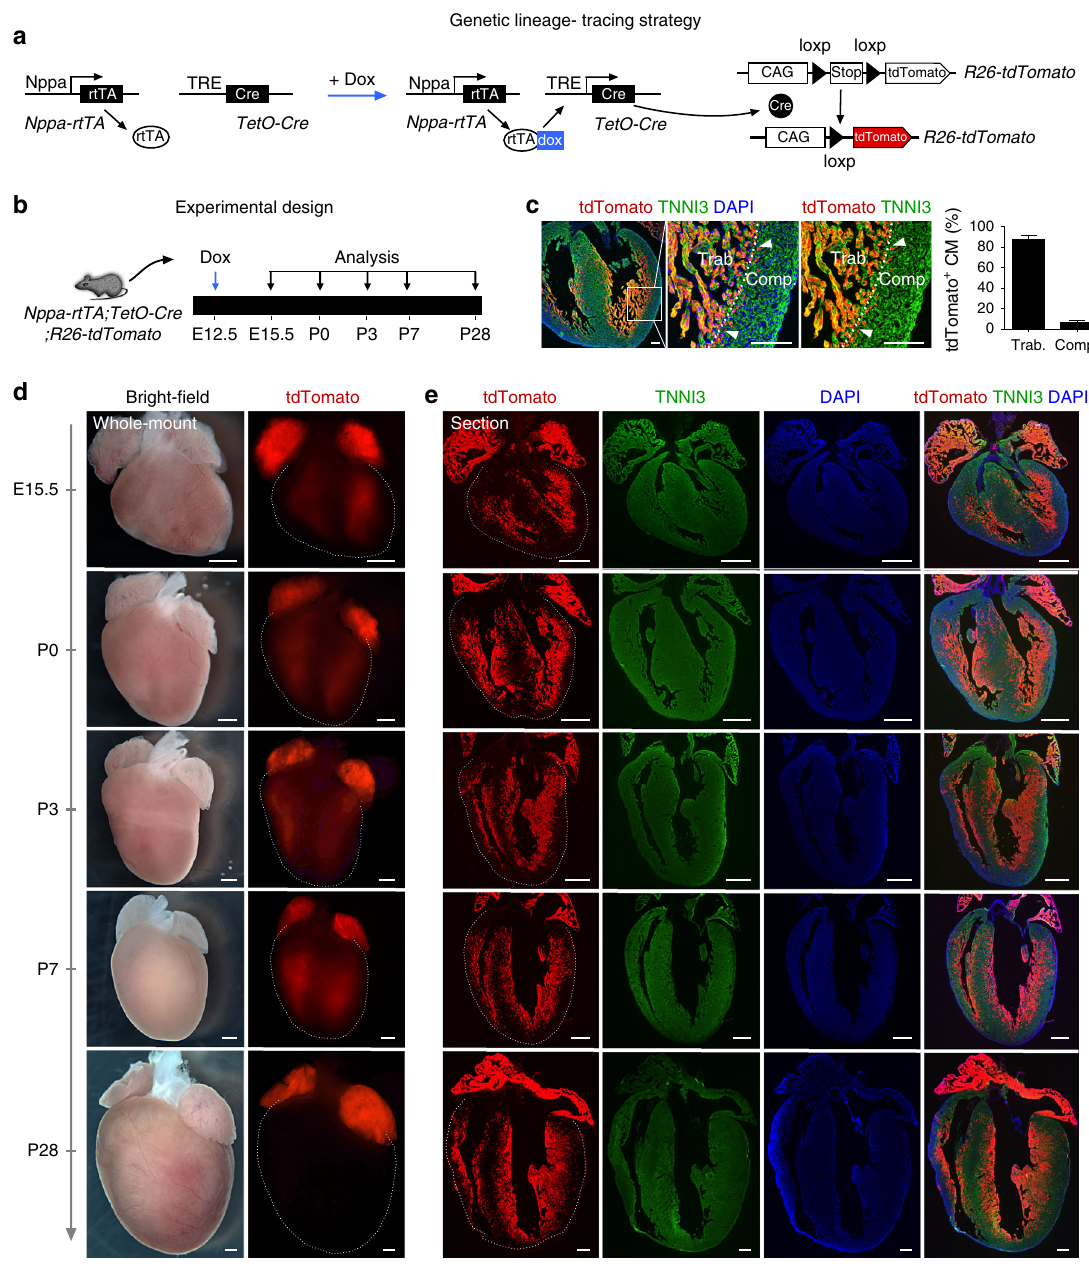
Fig. 3 Trabecular myocardium develops into the inner myocardial wall. a Schematic diagram showing the genetic labeling strategy of Nppa + cardiomyocytes by tet-on system. After doxycycline (Dox) treatment, rtTA binds to tetO promoter and drives Cre expression. Cre-loxp recombination leads to tdTomato expression. b Schematic diagram showing the time point for doxycycline induction and tissue analysis. c Immunostaining for tdTomato and TNNI3 on E15.5 heart sections. Arrowheads indicate a small number of Nppa + cells (tdTomato + ) in compact (Comp.) myocardium. Dotted line indicates border between trabecular (Trab.) and comp. myocardium. Quanti fi cation of the percentage of tdTomato + cardiomyocytes (CM) in Trab. or Comp. layer is shown on the right panel . Data are mean ± s.e.m.; n = 4. d Whole-mount bright- fi eld and fl uorescence views of hearts collected from Nppa-rtTA;tetO-Cre; R26-tdTomato mice. Dotted lines indicate the outline of hearts. e Immunostaining for tdTomato and TNNI3 on heart sections. Dotted lines indicate epicardium. Nuclei were stained with DAPI. Each image is a representative of four individual samples. Scale bars, 100 µ m in c ; 500 µ m in d , e